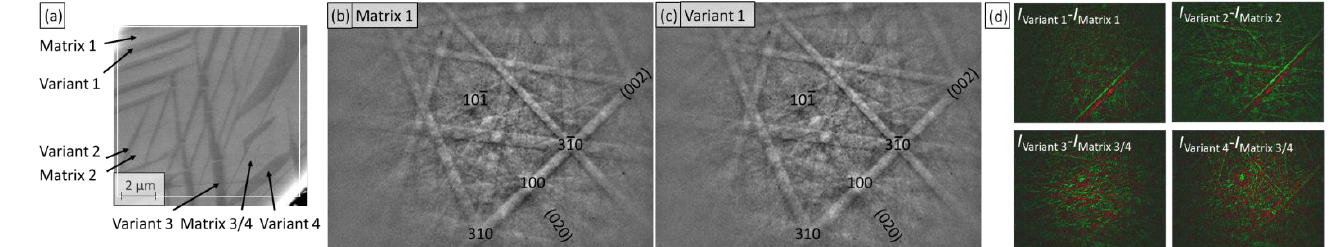
Figure 3. ( a ) Backscattered electron contrast image of the particle shown in Figure 2c. The four different variants and directly neighboring matrix regions are labeled. ( b , c ) Experimental EBSD patterns of the matrix 1 and variant 1 region averaged over 24 EBSD patterns. ( d ) Intensity difference images from experimental EBSD patterns of the regions indicated in ( a ). (Green: Intensity is higher in the EBSD pattern of the variant, Red: Vice versa.).